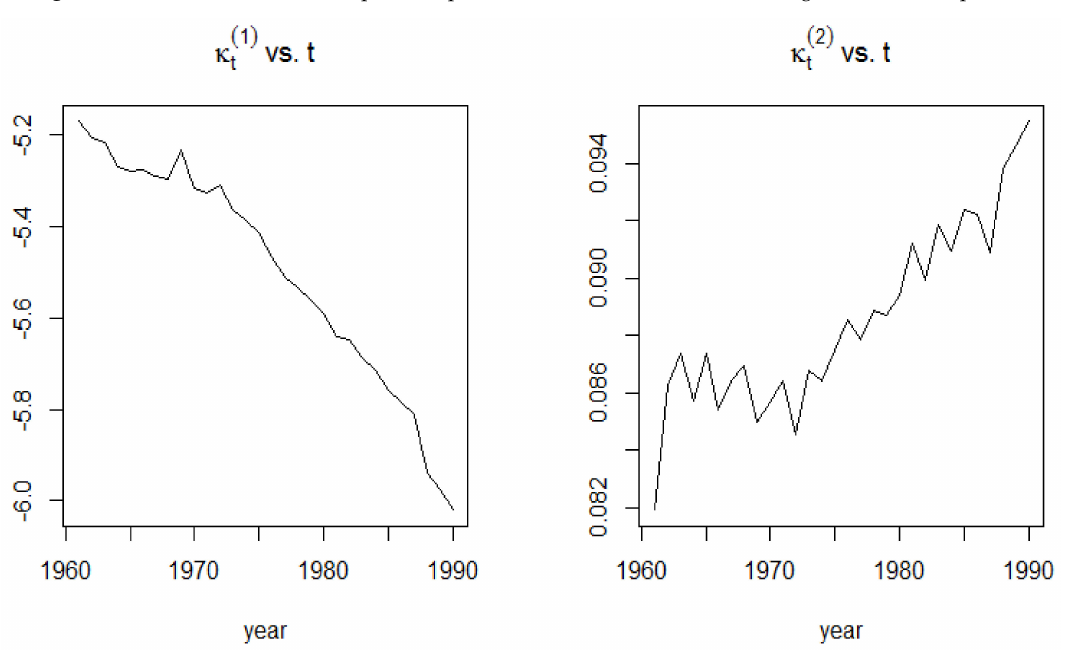
Figure 8. Plots of the two time-dependent parameters of the CBD model during the 1900–1938 period.